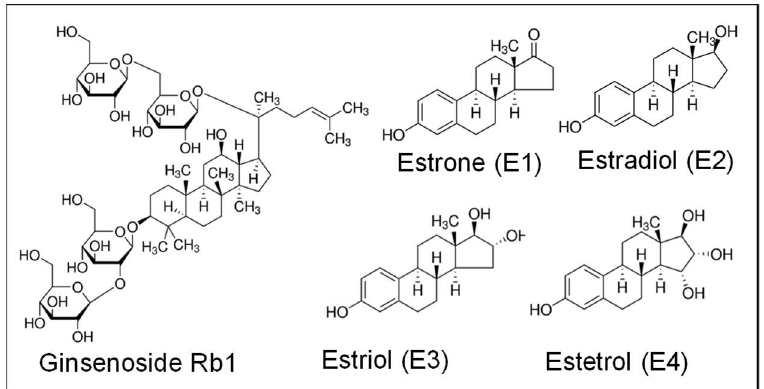
Figure 1. Chemical structures of ginsenoside Rb1 as well as natural forms of human estrogens. Ginsenoside Rb1 possesses 4 trans-ring rigid steroid skeletons with a modified side-chain at C20, C24-C25 double bound, and 4 glucose moieties. Estrone (E1), estradiol (E2), and estriol (E3) are the major naturally occurring forms of estrogens in females. Estetrol (E4) is produced only during pregnancy. It is reported that estrogen acts as an antioxidant via stimulation of antioxidant enzymes, thus reducing the production of ROS [35–37]. Estrogen also exerts radical scavenging effects by increasing